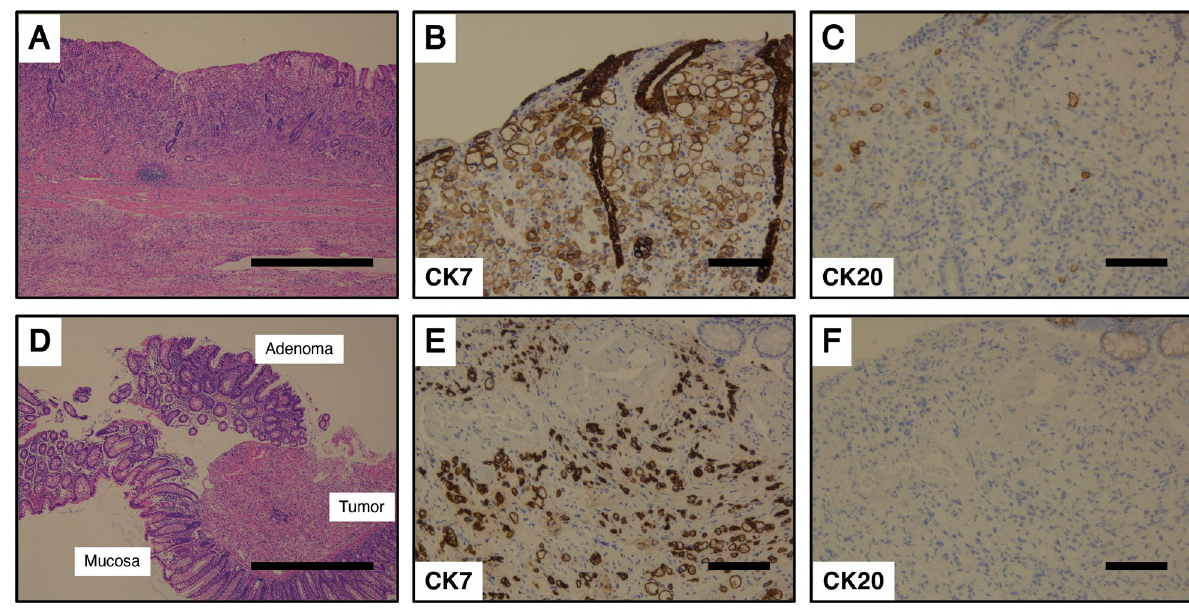
Fig. 5 A – F Histologic examinations of the gastric and colonic tumors. A Hematoxylin and eosin staining of the gastric tumor shows poorly differentiated adenocarcinoma with signet ring cell carcinoma ( 20). Scale bar, 1000 μm. B , C Immunohistochemistry staining of the gastric tumor × cells yields positive results for CK7 ( B ; 200) and negative results for CK20 ( C ; 200). Scale bar, 100 μm. D Hematoxylin and eosin staining of the × × colonic tumor shows poorly differentiated adenocarcinoma with signet ring cell carcinoma ( 20). The mucosal surface of the colonic tumor shows × normal mucosa with partial features of adenoma. Scale bar, 1000 μm. E , F Immunohistochemistry staining of the colonic tumor cells yields positive results for CK7 ( E ; 200) and negative results for CK20 ( F ; 200). Scale bar, 100 μm. CK × ×